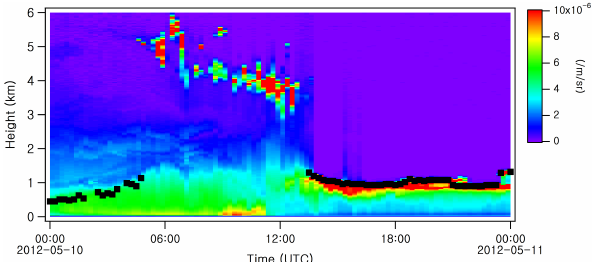
Figure 3. Time plot of attenuated backscatter coefficients observed from the two-wavelength Mie lidar at Seoul National University, and boundary layer height (marked by black squares) retrieved by the automated wavelet covariance transform (WCT) method of Brooks (2003). Table 2. Statistical summary of AOD and cloud-screened AOD (AOD cl ) observed by AERONET and MODIS during the DRAGON-Asia campaign period. AERONET